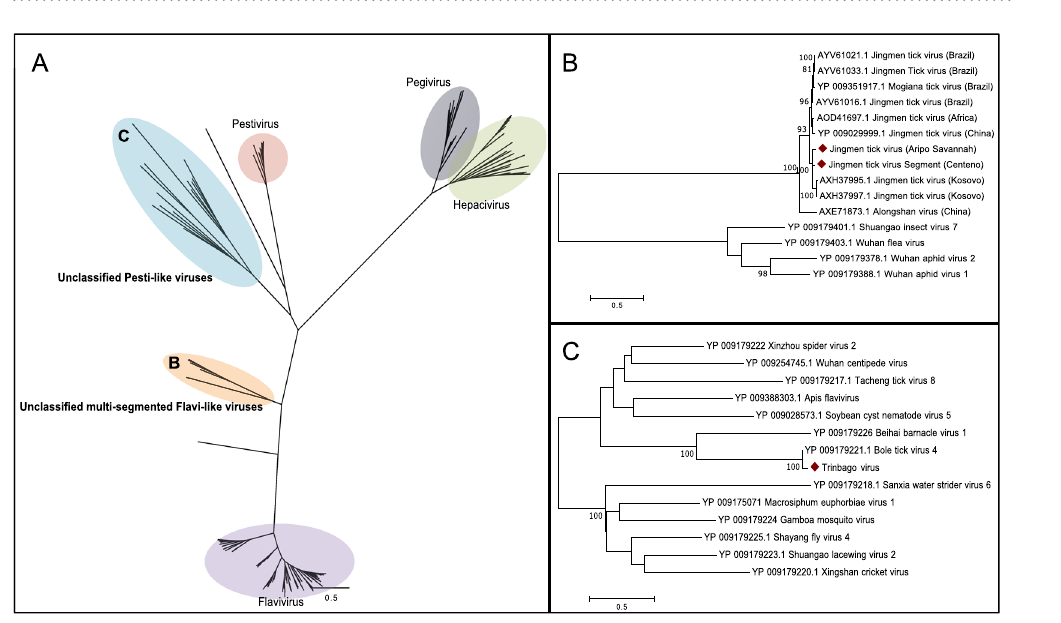
Figure 5. Phylogenetic relationship of Rhabdoviridae based on a 1,255-aa alignment of the RdRp.